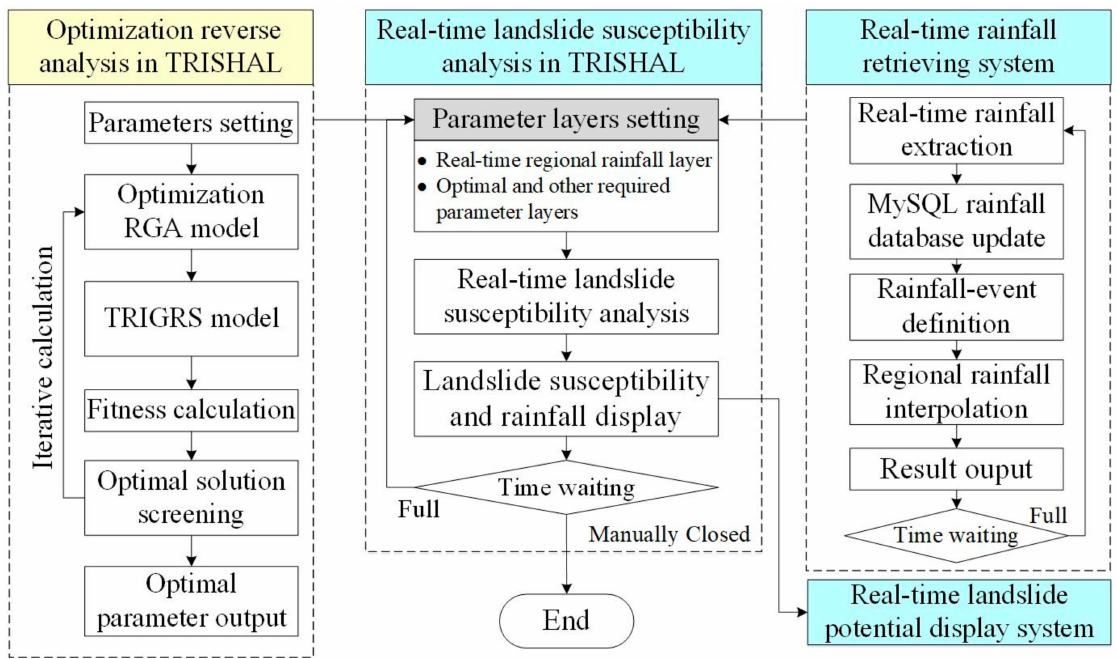
Figure 1. The configuration of the real-time nowcasting system for regional landslide